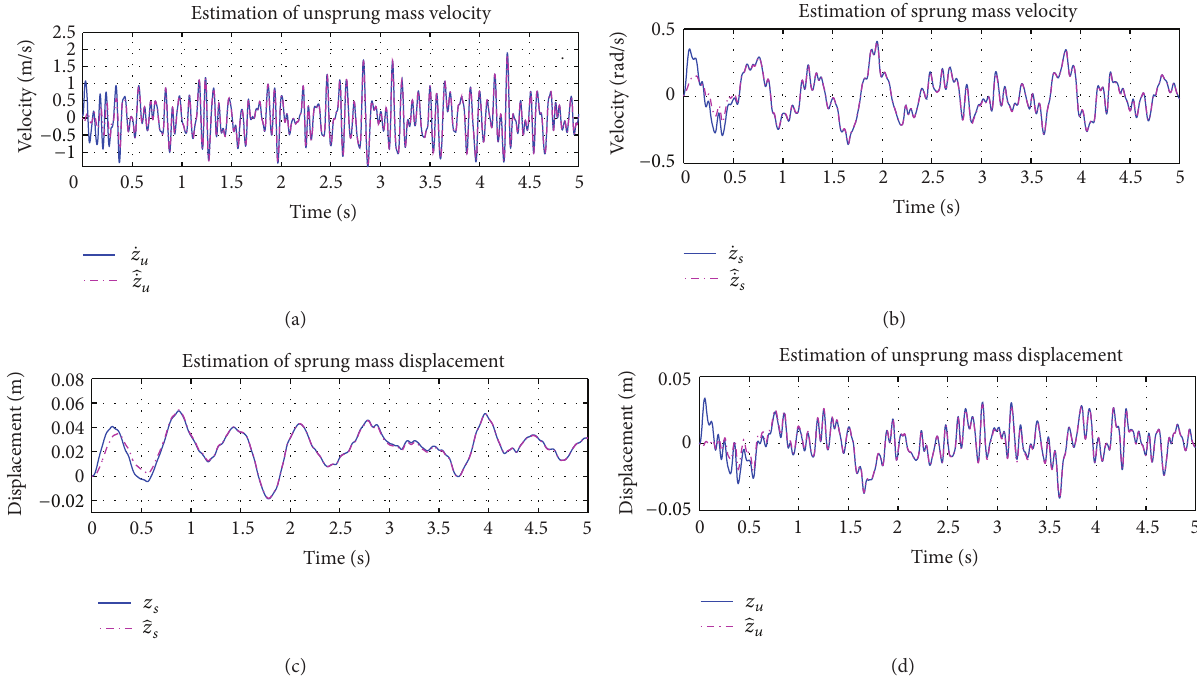
Figure 4: (a) Estimated unsprung mass velocity, (b) estimated sprung mass velocity, (c) estimated sprung mass displacement, (d) estimated unsprung mass